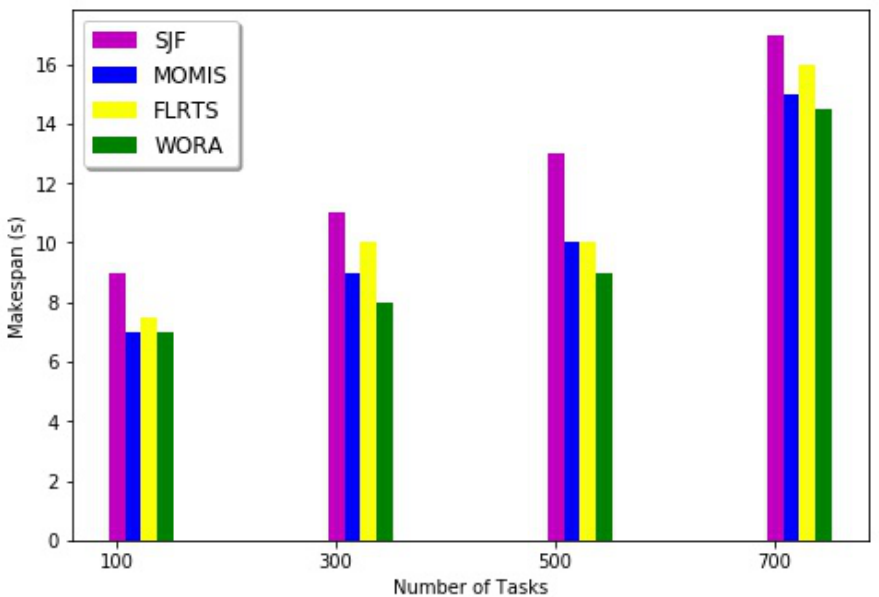
Figure 13. Computation of makespan of tasks with 15 fog nodes.